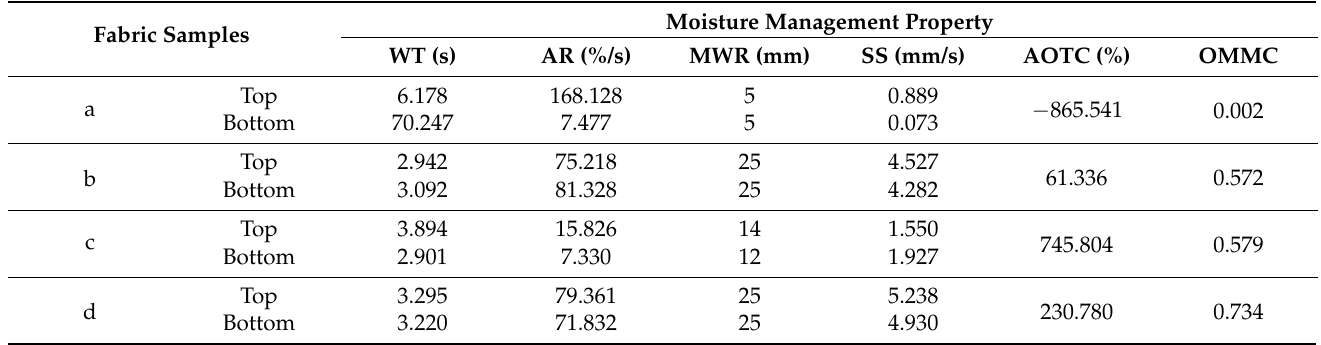
Table 2. The moisture management property of the